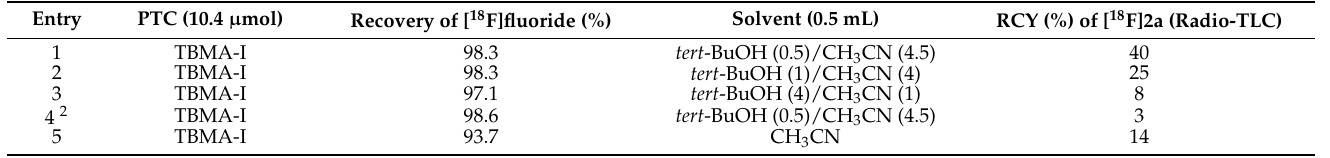
Table 3. Radiofluorination of 1 with TBMA-[ 18 F]fluoride eluted with MeOH 1 .